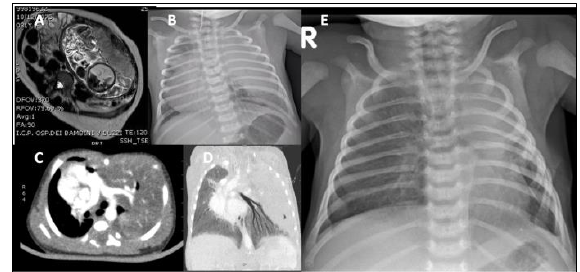
Figure 3: Large left-sided complicated lesion not submitted to fetal therapy for parental refusal: fetal MRI (A), chest X-ray (B) and CT scan (C, D) at birth; the child needed mechanical ventilation at birth and required open surgery by the first 24 hours of life (E: postoperative chest